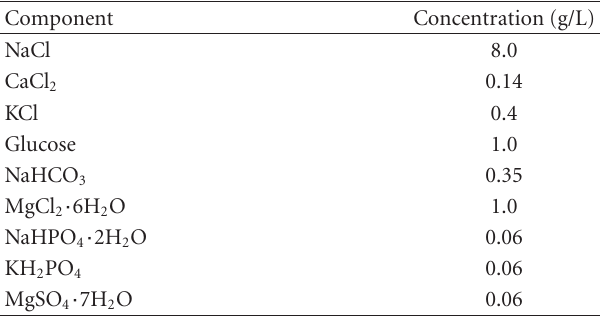
Table 1: Hank solution